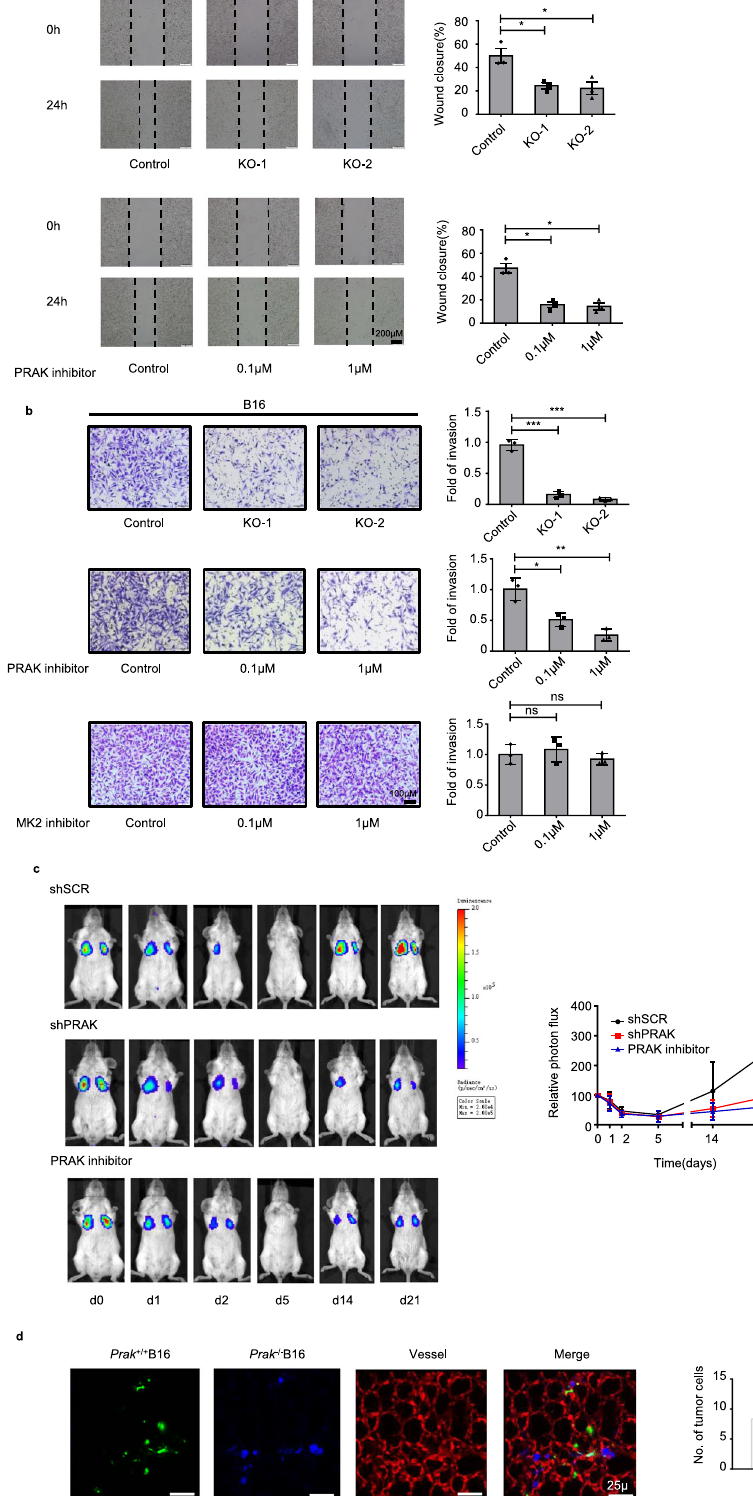
pulsed with [ 35 S]-L-methionine and [ 35 S]-L-cysteine. HIF-1 α was immunoprecipitated from the cell lysate, resolved by SDS-PAGE, and detected by autoradiography. As shown in Fig. 5d, loss of function of PRAK resulted in a drastic reduction in the synthesis of nascent HIF-1 α proteins. Therefore, PRAK controls HIF-1 α expression primarily through translational